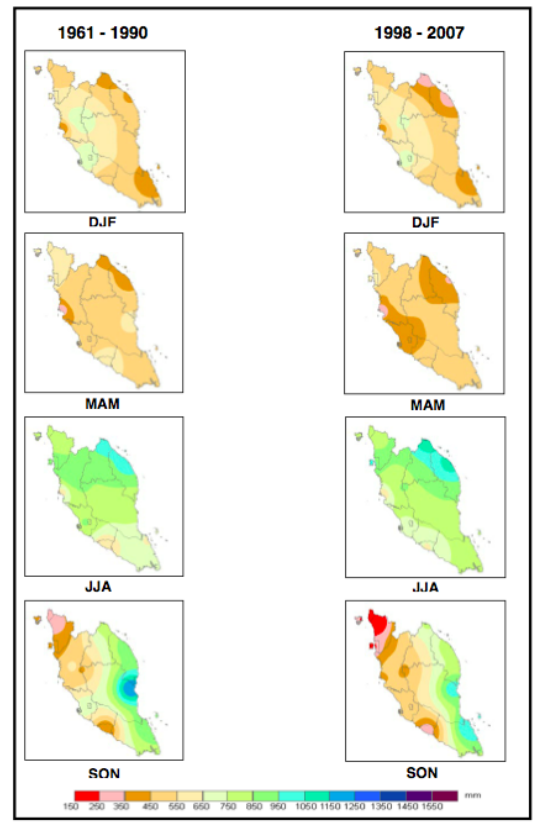
Figure 14. Long ‐ Term Mean Rainfall for Peninsular Malaysia. Colours indicate the total rainfall in mm. DJF ‐ December, January, February. MAM ‐ March, April, May. JJA ‐ June, July, August. SON ‐ September, October, November (Courtesy: Malaysia Meteorological Department).